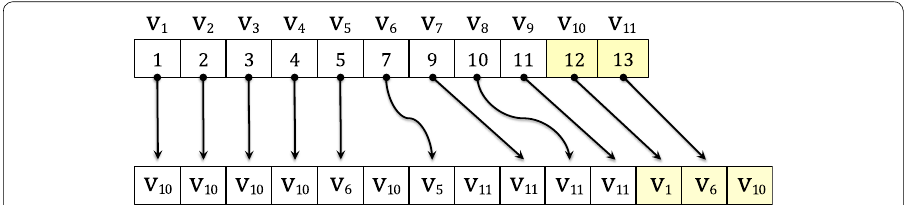
Fig. 2 Generalized CSR/CSC Data Structures (In-memory graph encoding). Cost of this particular in-memory graph encoding is 11 (or O ( | V | + | C | ) ) for the ptr array (top) whereas the other is only 14, for a total of 27. This is compared to the popular CSC/CSR that requires arrays of size 9 and 34 for a total of 43. Thus, the simple encoding reduces the storage costs quite significantly (as well as IO costs, while improving algorithm performance as the computational costs of many graph primitives are also reduced using this encoding. Moreover, it is guaranteed to improve caching. Note that storing the graph to disk in a lossless fashion is even more efficient, since one can simply write “ v 1 v 6 v 10 ” as the first line, followed by the edge v 5 v